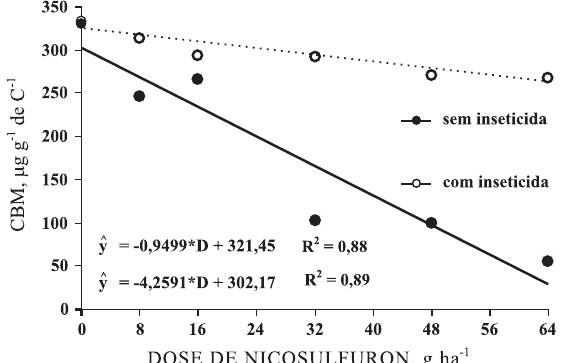
Figura 3. Carbono da biomassa microbiana (CBM) de amostras de solo, 75 dias após a aplicação de doses do herbicida nicosulfuron em diferentes doses, isolado ou simultaneamente ao insetici- da chlorpyrifos (240 g ha -1 ). D = doses; *: signifi- cativo pelo teste t a 5 %.